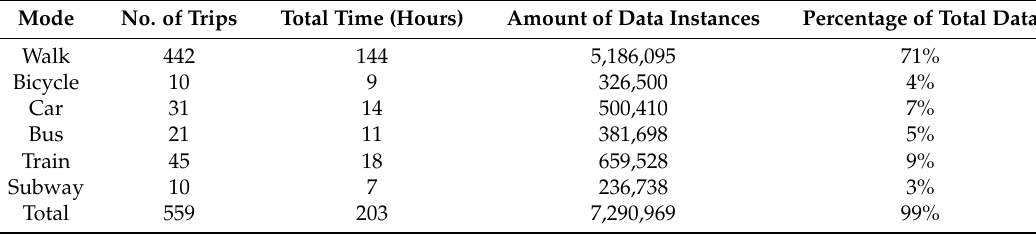
Table 3. Amount of data recorded by